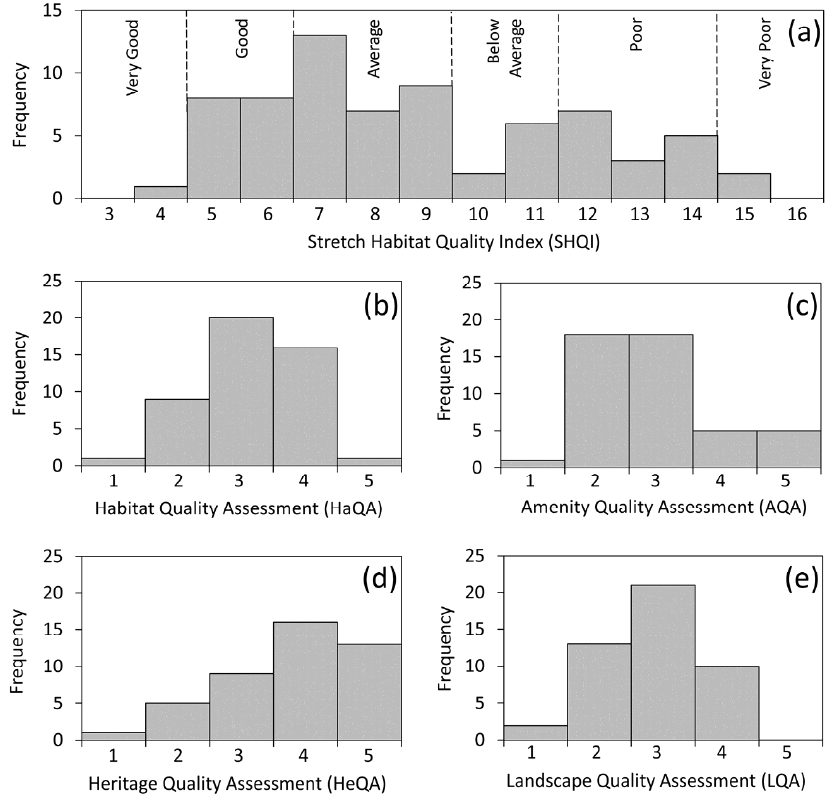
Figure 5. Frequency distributions of ( a ) SHQI, ( b ) HaQA, ( c ) LQA, ( d ) AQA, and ( e ) HeQA values from the River and Study Area Surveys (completed 2014-18). Full definitions and descriptions of the indices are provided in the Supplementary Information (2) PlaceMarker: Classifications and Indices .